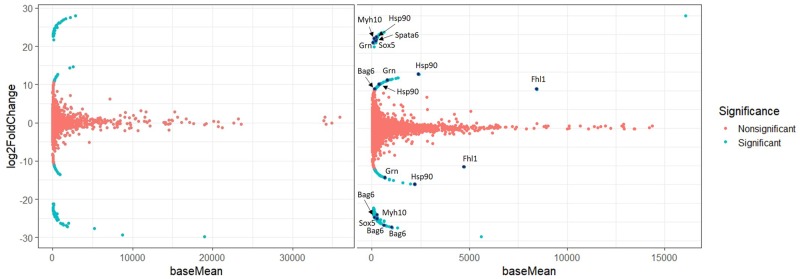
—DE of liver (left) and testis (right) transcriptomes of clade A versus clade B. baseMean, mean of normalized counts of all samples; log 2-fold change, log 2 scale to minimize differences between samples and represents change in upregulation or downregulation of DE of the transcript. Blue dots represent differentially expressed genes with a P adjusted ≤ 0.01 and pink dots represent differentially expressed genes with a P adjusted > 0.01. Genes mentioned in the Discussion section of this article are labeled in the DE plot of testis.